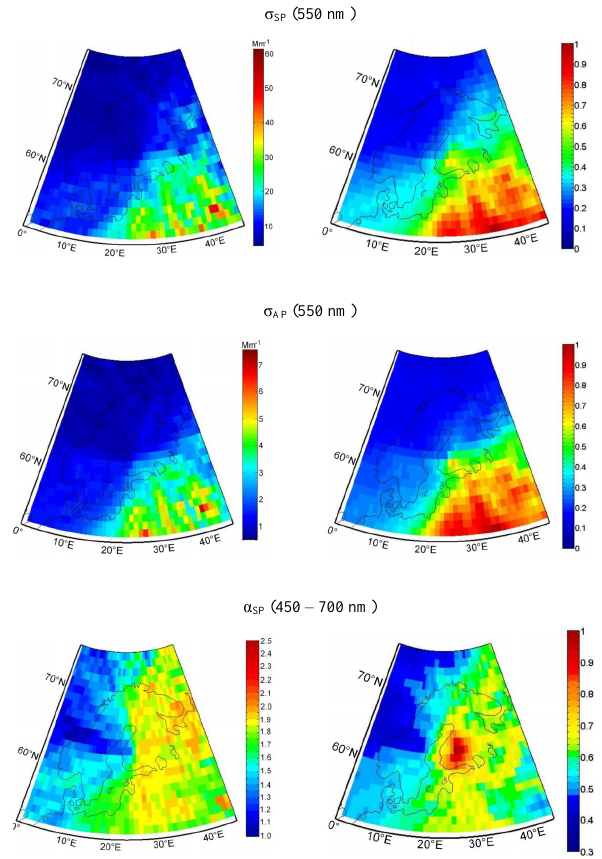
Fig. 18. Trajectory statistics of scattering and absorption coeffi- cients at λ = 550nm and the ˚Angstr¨om exponent of scattering. Left: absolute values, right: normalized values, see text for